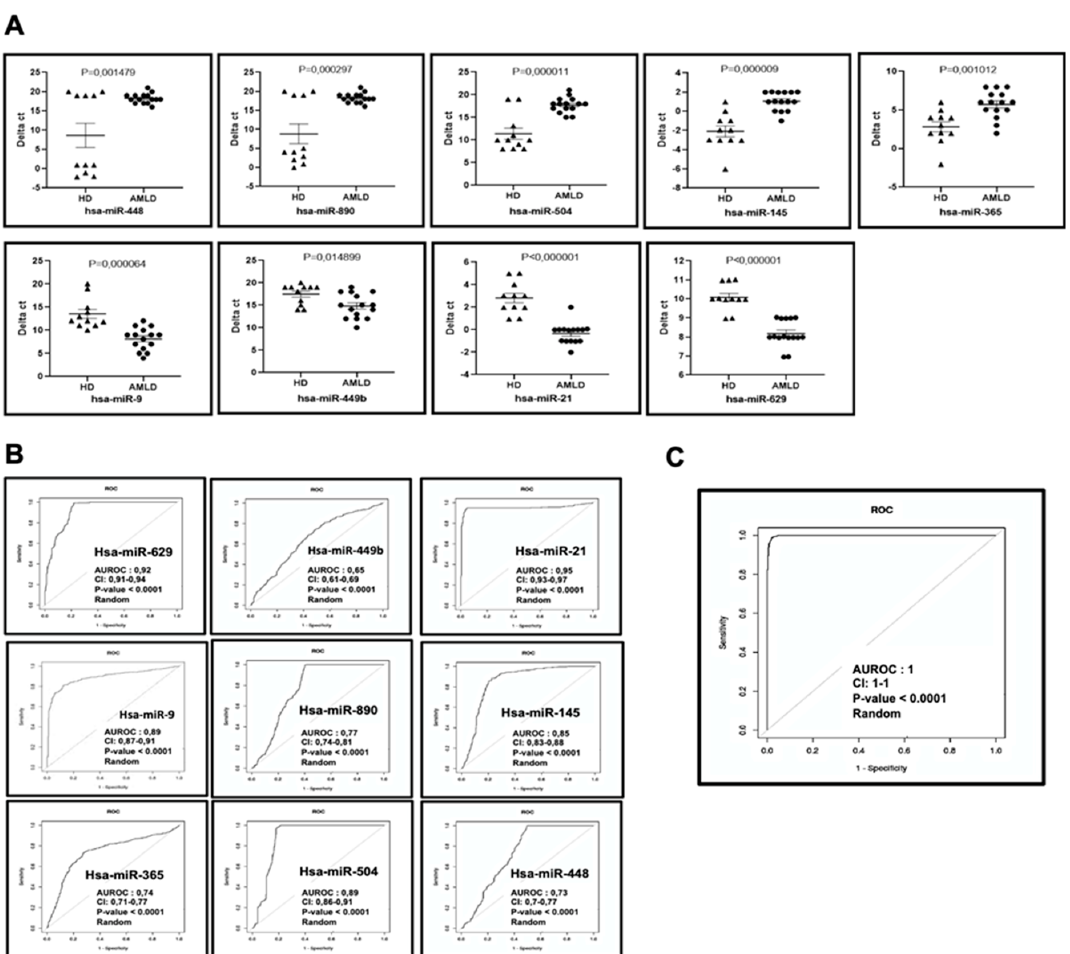
Figure 3. Confirmation of differentially expressed miRNAs in a second cohort ( n = 15).( A ) The dot plots of Downregulated and Upregulated AML miRNA signature in a second cohort of AML patients at diagnosis compared to HD ( B ) ROC curves reflecting the performance of the individual features of the 9 miRNA signature in discriminating AML patients from healthy donors. ( C ) ROC plot showing the discriminatory value of the 9-miRNA signature in the second cohort. AUROC: Area Under ROC; CI: 95% Confidence Intervals; p -value: correspond to a Mann-Whitney U test addresses testing the null hypothesis of the AUROC is 0.5 (i.e., the classifier is random).